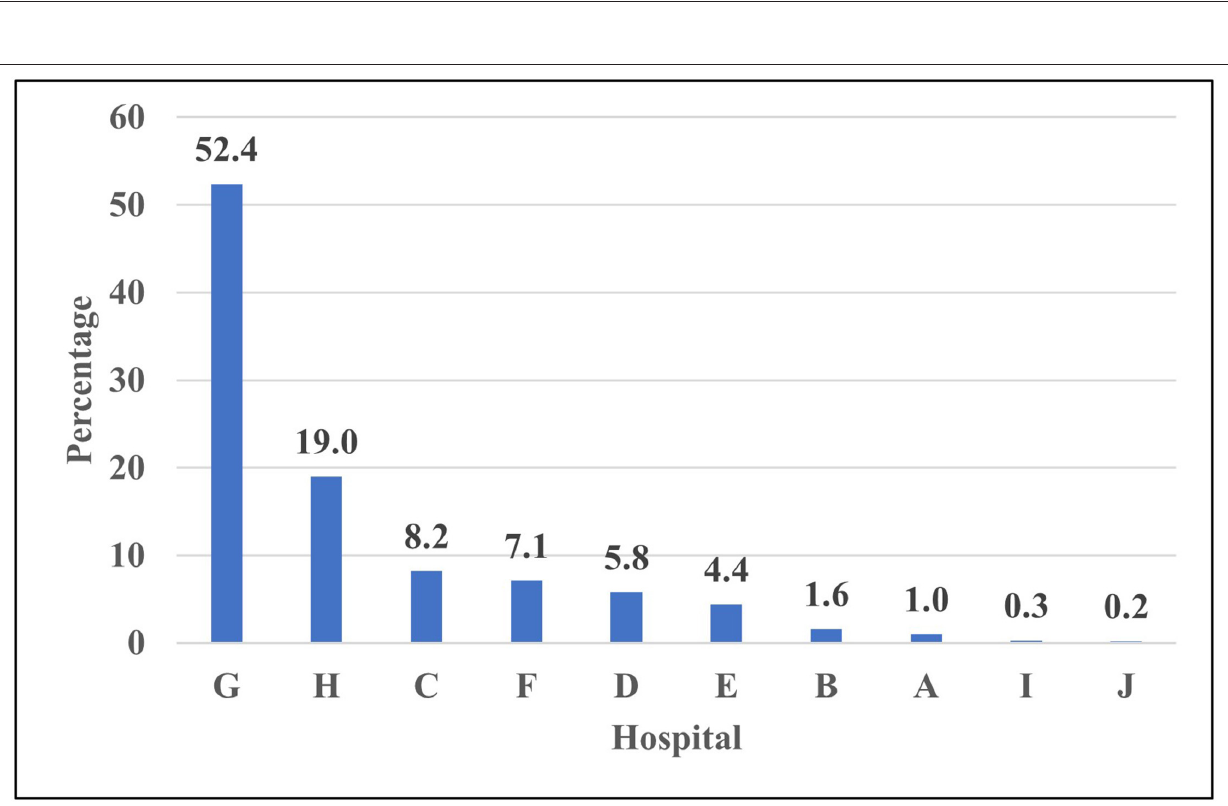
Frontiers in Public Health |